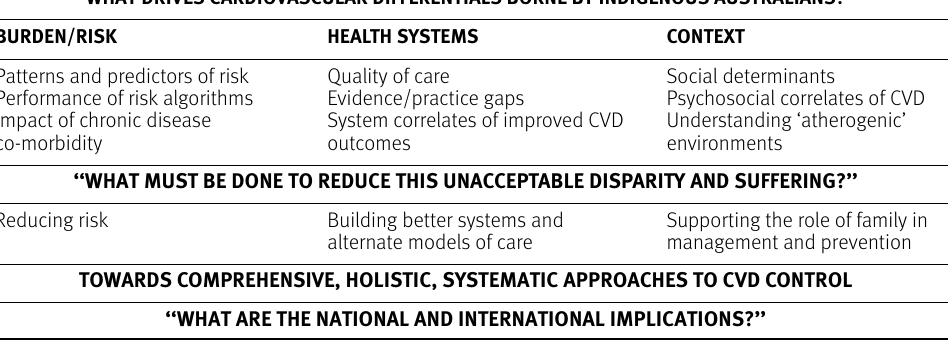
Table 1. Strategic CVD research within Central